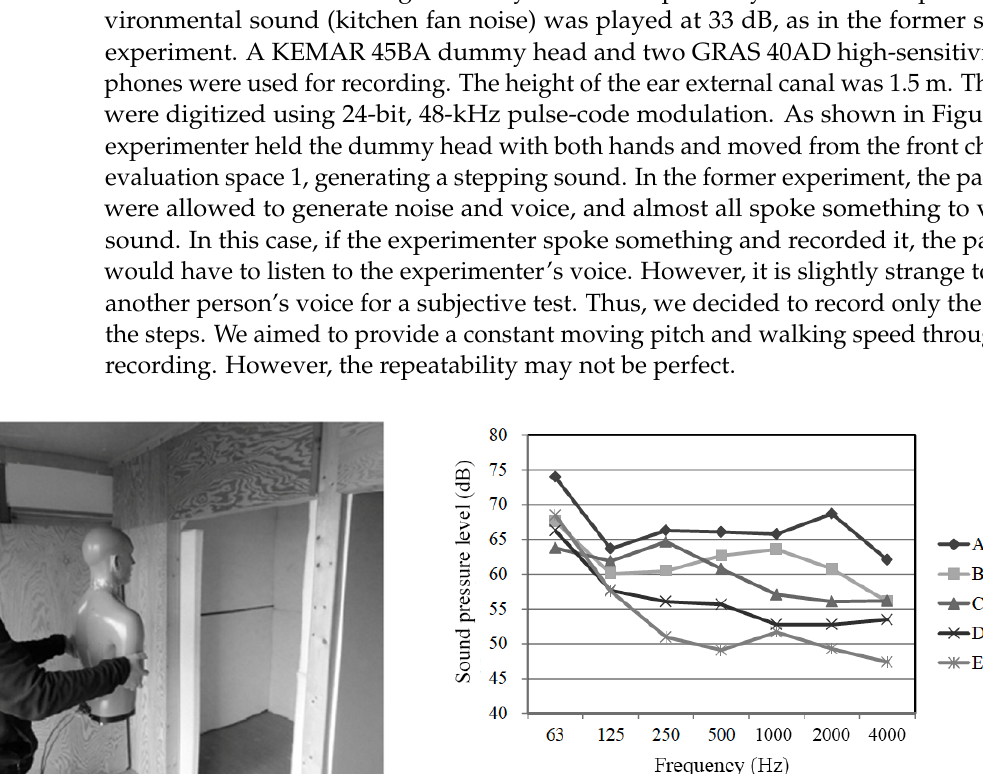
Figure 5. Results of psychological experiments using the full-scale room model. The eight figures show the psychological values of the five absorption patterns (A–E) for each subjective item. The error bars represent the 5% significant yardsticks.